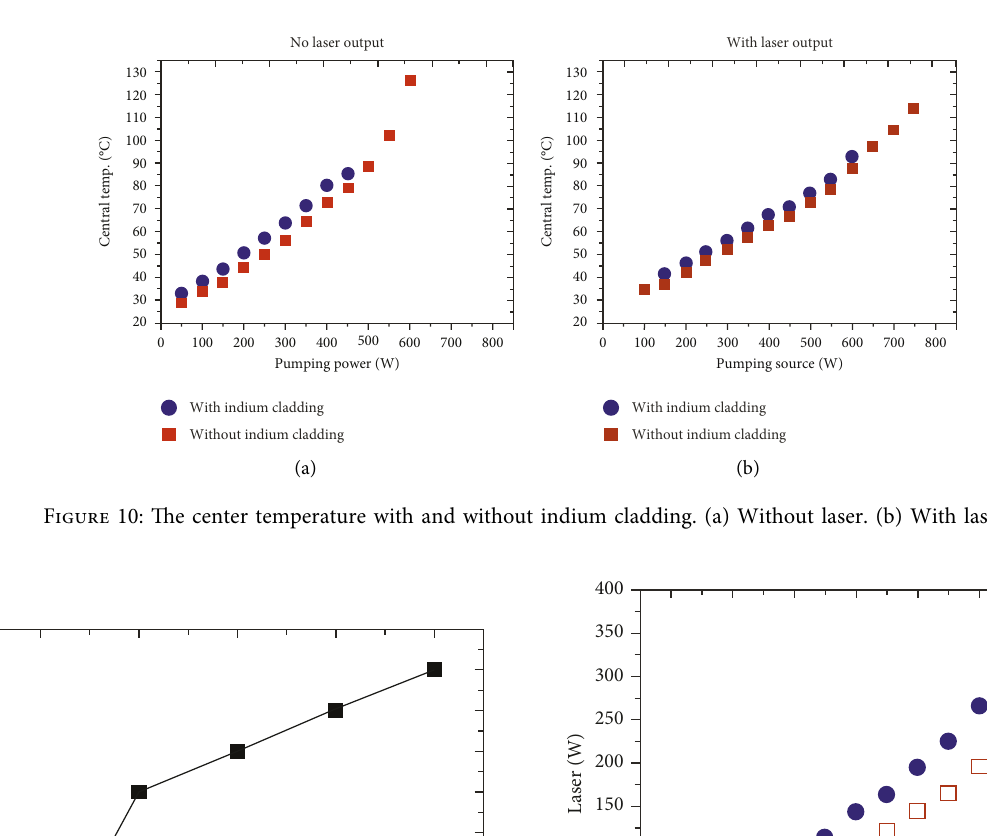
Figure 9: The edge temperature with and without indium cladding. (a) Without laser. (b) With laser.